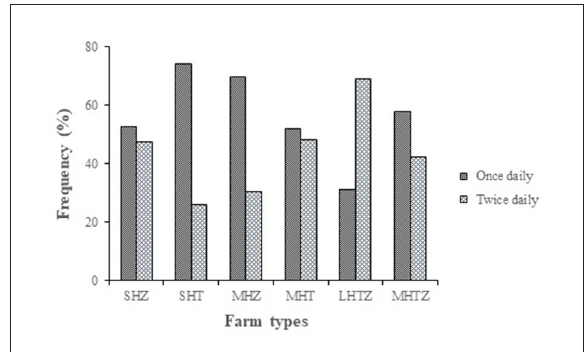
FIGURE4 Grazing frequency per day across dairy cattle farm types in peri-urban areas of south Benin.